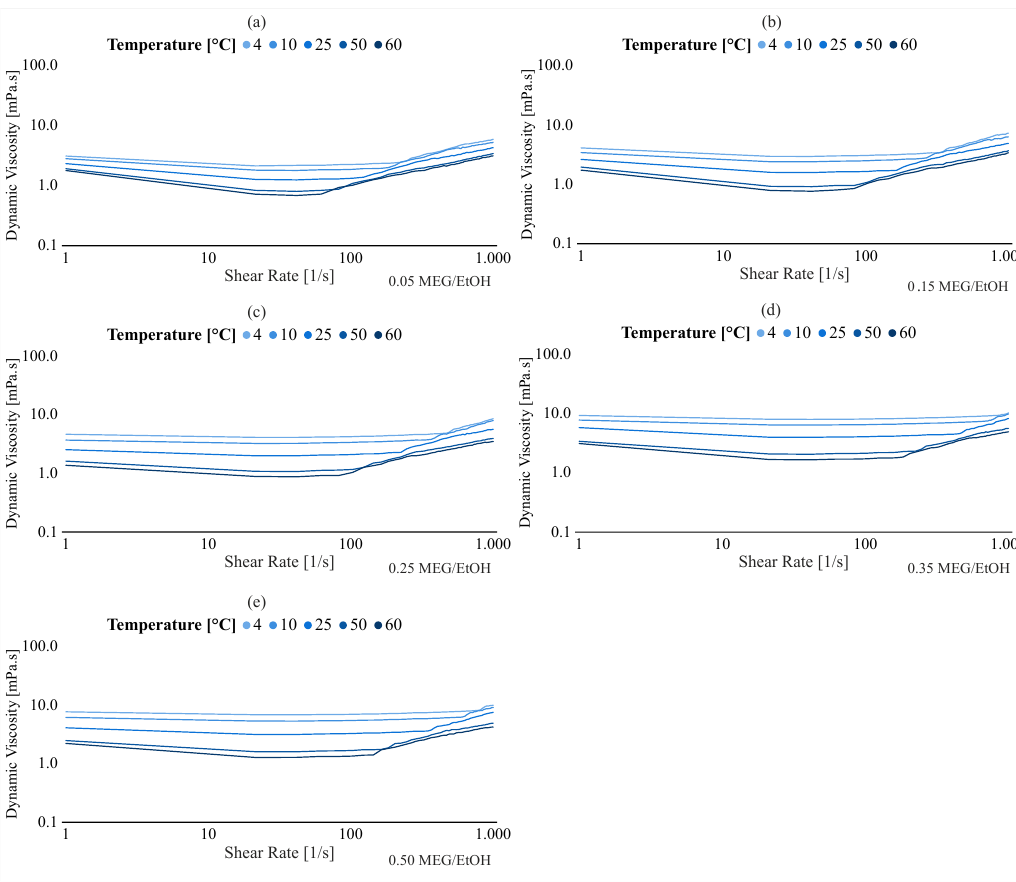
Figure A1. Dynamic viscosity of the MEG/EtOH mixture as function of shear rate for different temperatures, ( a ) 5%MEG/EtOH, ( b ) 15%MEG/EtOH, ( c ) 25%MEG/EtOH, ( d ) 35%MEG/EtOH, ( e )